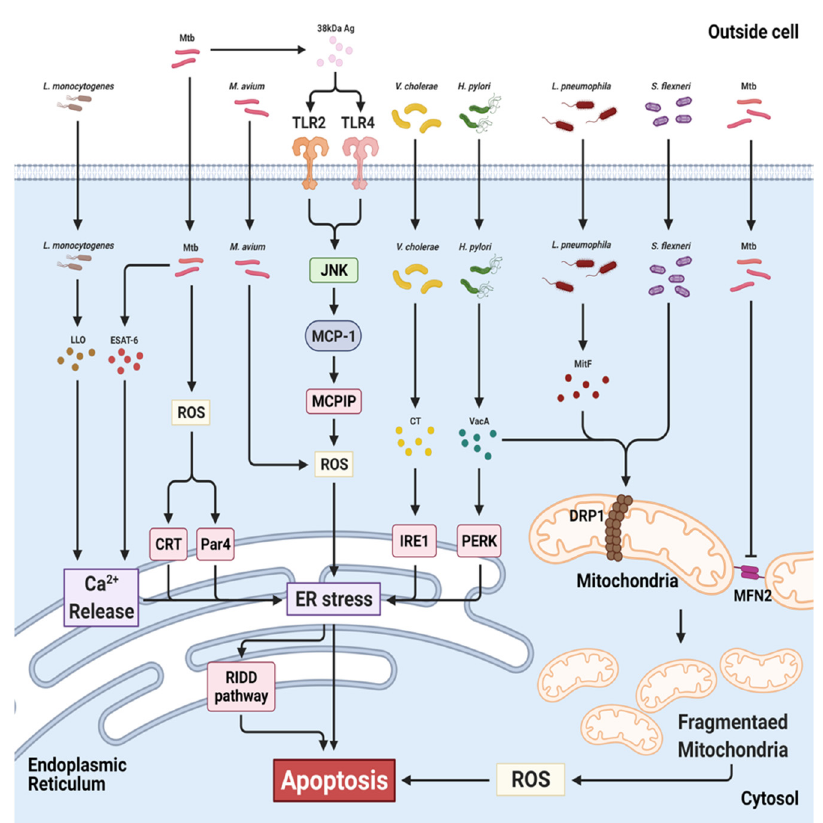
Figure 5. Targets of bacteria in ER and mitochondria during infection. Mtb induces ER stress-mediated apoptosis via ROS, calreticulin (CRT), Par-4 (Par4) and Ca 2+ release. M. avium increases ROS-mediated ER stress, leading to activation of the RIDD pathway. Cholera toxin (CT) of V. cholera phosphorylates IRE1. Helicobacter pylori secretes VacA, leading to activation of PERK and DRP1. L pneumophila and S. flexneri induce mitochondrial fragmentation in a DRP1-dependent manner. Mtb also triggers mitochondrial fragmentation by inhibiting MFN2. Mtb, Mycobacterium tuberculosis ; M. avium, Mycobacterium avium ; L. monocytogenes, Listeria monocytogenes ; H. pylori, Helicobacter pylori ; V. cholera, Vibrio cholera ; L pneumophila, Legionella pneumophila ; S. flexneri, Shigella flexneri. (Created with BioRender.com accessed on 29 March 2021).